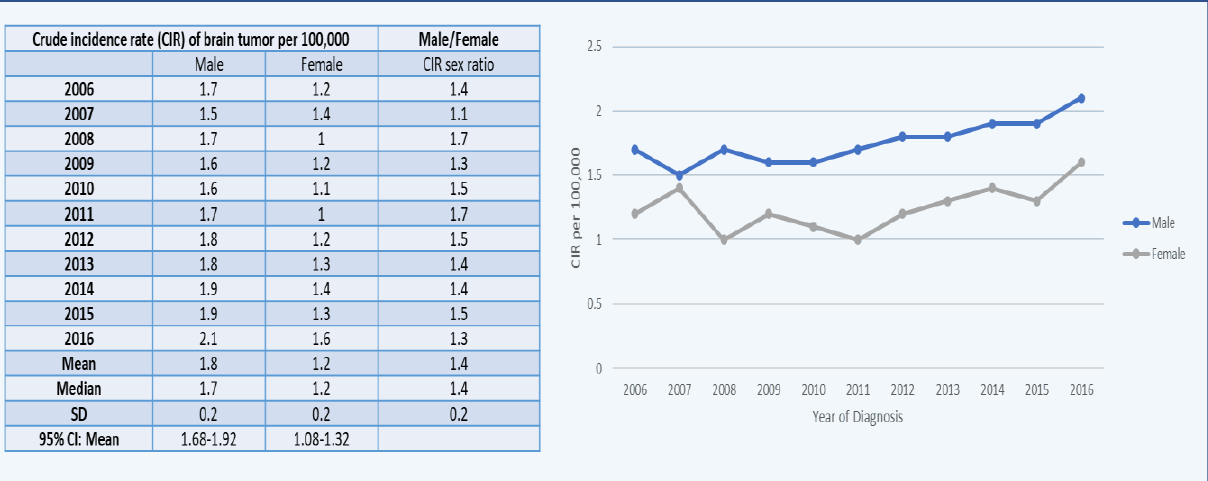
Figure 2. CIRs of brain tumor cases per 100,000 between male and female populations from 2006 to 2016.